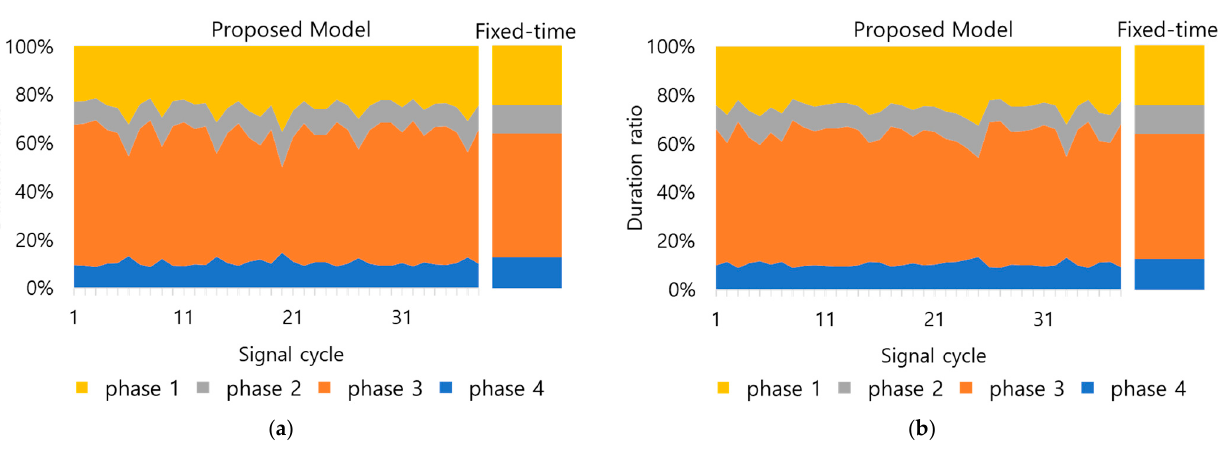
Figure 3. Simple network with two intersections.